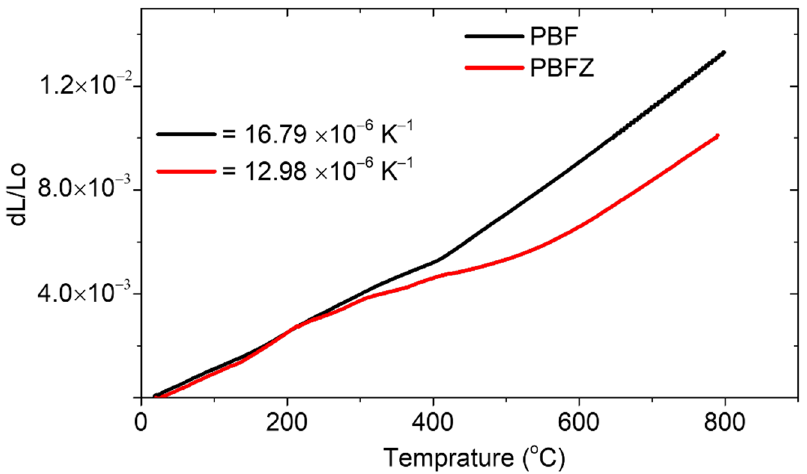
Figure 3. Thermal expansion curve of PrBaFe 1.9 Zn 0.1 O 5+ δ and PrBaFe 2 O 5+ δ between room temperature and 800 °C.